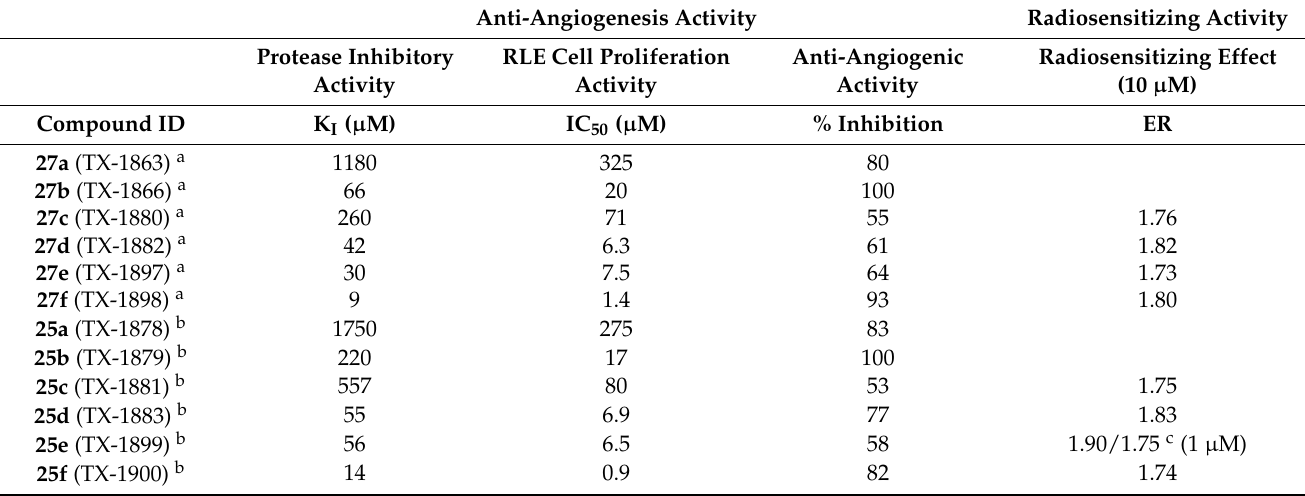
Table 1. Inhibition data of dual-function Misonidazole